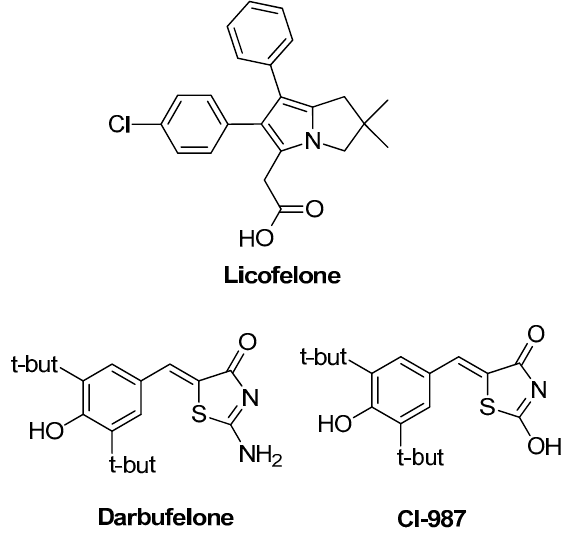
Figure 1. Chemical structures of Licofelone, Darbufelone and CI-987.